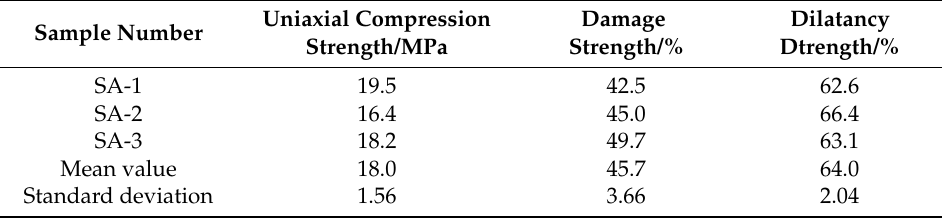
Table 1. Damage and dilatancy strength for salt rock samples under uniaxial compression.